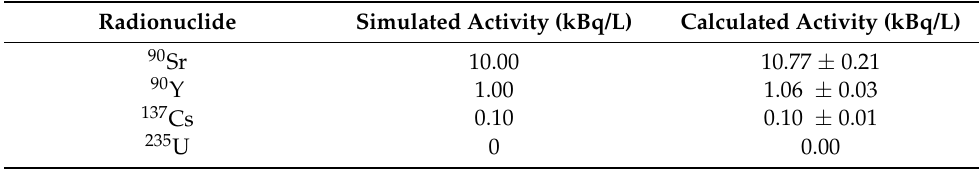
Table 7. The estimate of 90 Sr , 90 Y and 137 Cs activity from a realistic groundwater